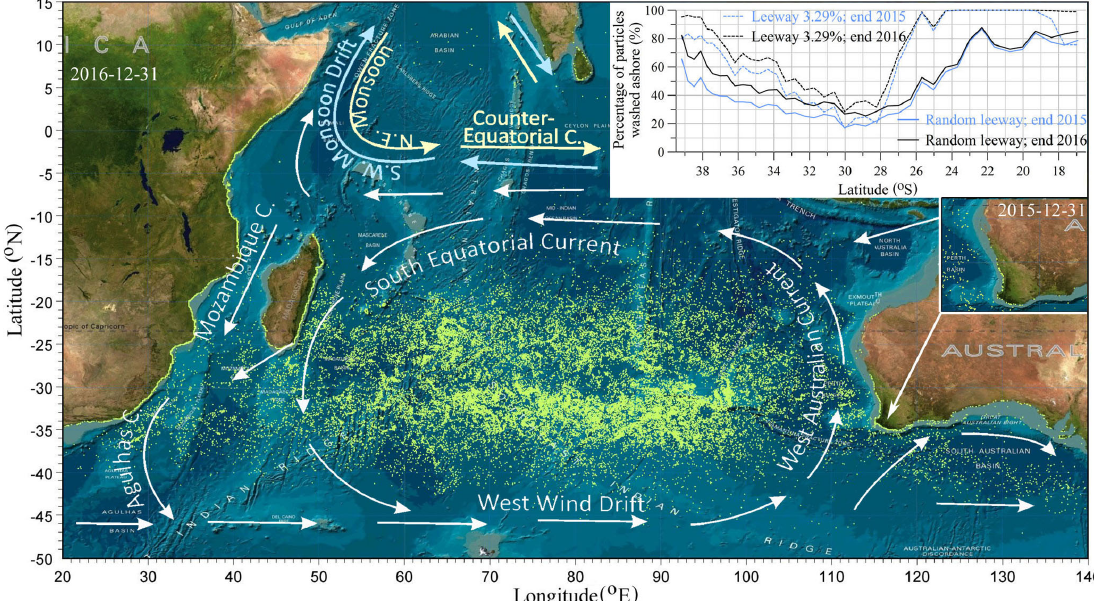
Figure 9. Snapshot of particle locations on 31 December 2016 (random leeway model; origin no. 23) and percentages of particles washed ashore.